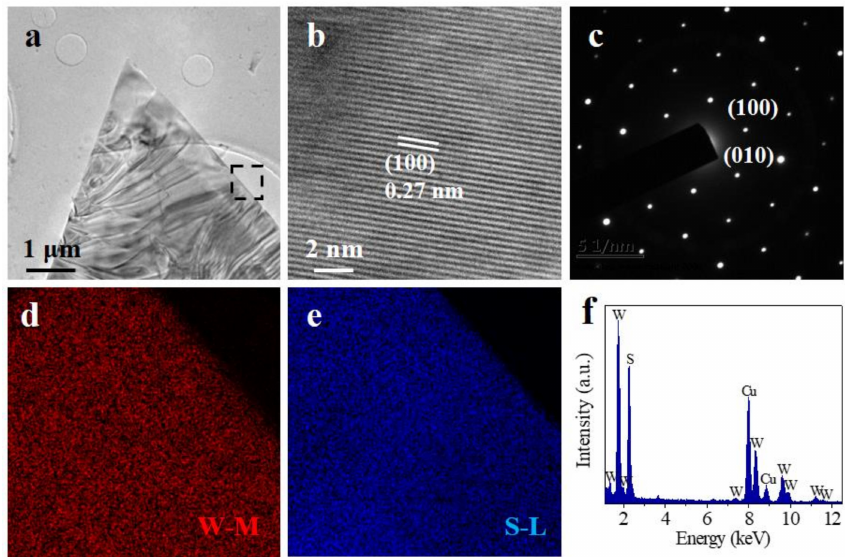
Figure 4. ( a ) Low-magnification TEM image of the WS 2 triangle flake. ( b ) High-resolution TEM image and ( c ) SAED pattern image of the WS 2 triangle flake. ( d , e ) W and S elemental mapping in the black rectangle region of the WS 2 flake in ( a , f ) EDX spectrum of the WS 2